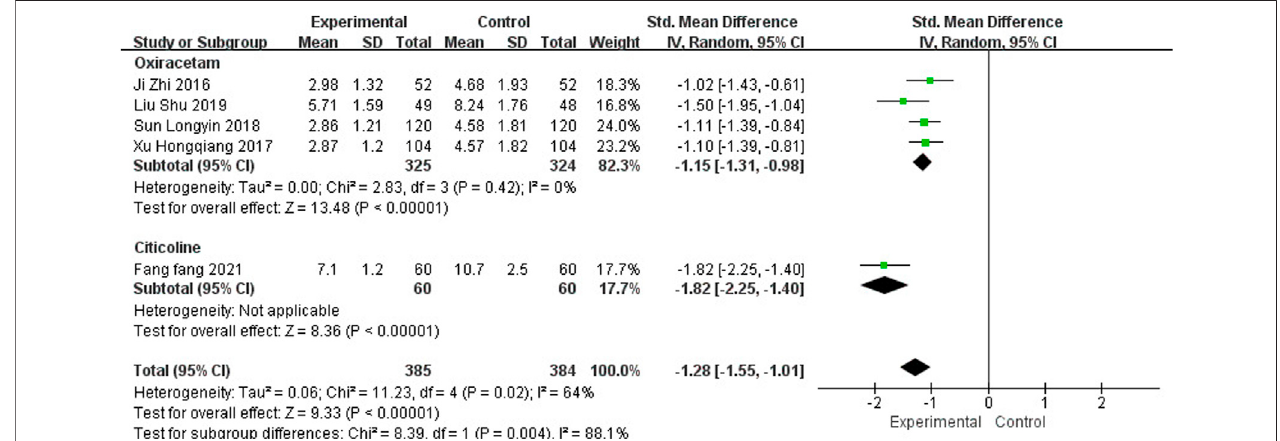
FIGURE 10 | Meta-analysis of NIHSS by NBP as combination therapy.